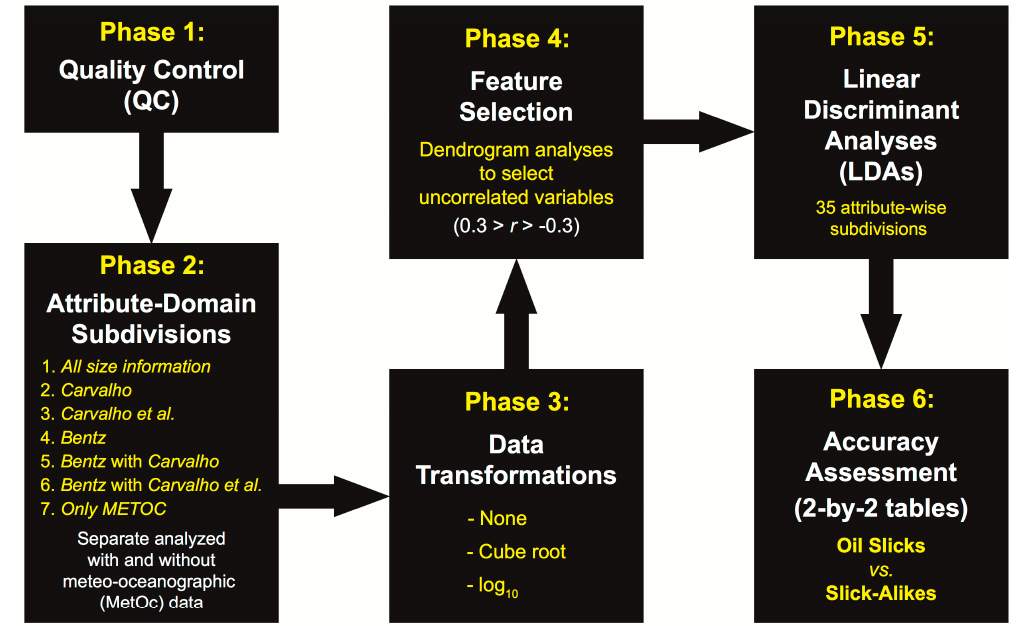
Figure 3. Research strategy for the evaluation of linear multivariate analysis algorithms aimed at classifying information from a dataset of SAR-derived, low-backscatter regions into mineral oil slicks or other environmental look-alike targets (non-petroleum signals). The six phases are described in the text, Sections 2.3.1–2.3.6. “Carvalho” refers to [18,21], see Section 1.1.2. “Carvalho et al.” corresponds to [22–24], see Section 1.1.3. “Bentz” is associated with [17], see Section 2.2.2.1.